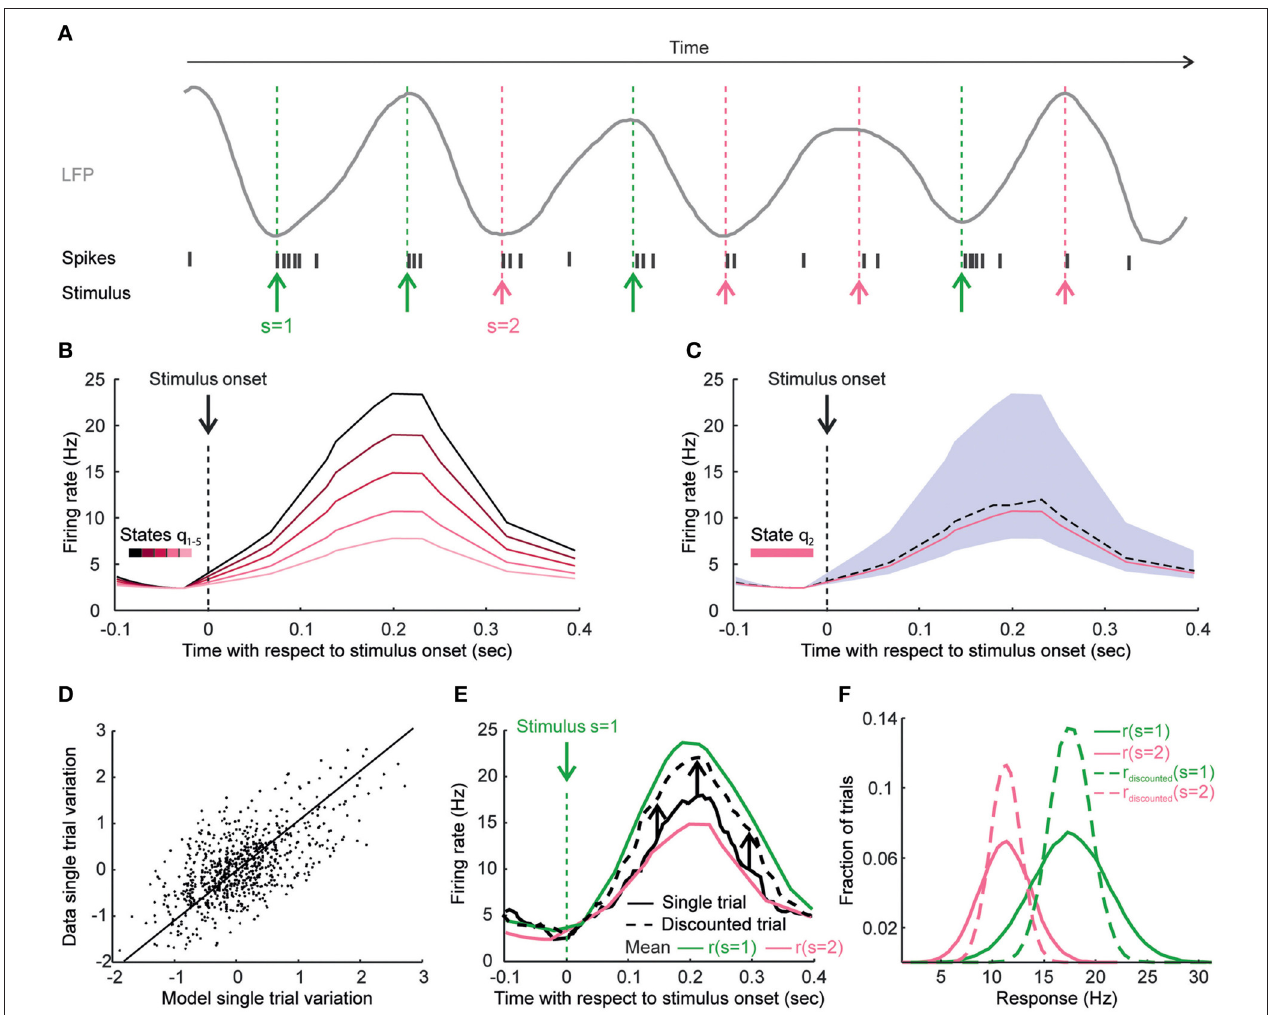
FIGURE 2 | How knowledge of state dependence may be used to improve reliability of elicited patterns and to enhance decoding of neural activity. This figure uses cartoons of neural responses to illustrate how taking into account state dependence of neural responses may improve BMIs. (A) The panel illustrates the responses of a cartoon neuron to two different stimuli presented at different phases of LFP. Green and pink arrows represent the application times of stimulus s = 1 and s = 2, respectively. Stimuli applied at the trough of the LFP (a more excitable network state phase) elicit a stronger response than stimuli applied at the peak of the LFP (a less excitable network state phase). (B) We plot the time course of cartoon neural activity shortly after a stimulus is applied at time t = 0. Different lines represent single-trial responses to the same stimulus that were elicited in trials that differed by the value of the state variable (in this case, the LFP phase) in each trial. Each line representing the single-trial responses is color-coded by the value of the state variable in that trial. The response to the same stimulus has large trial-to-trial variability because of the difference in the state at which the stimulus is presented. (C) In a particular network state, the real response (dashed black line) and the state-dependent model prediction (pink line) of the response are shown. If the model of state dependence is accurate, it will help the experimenter to predict which response will be elicited in that trial given the stimulation parameters and the neural state, thereby narrowing down the uncertainty about which response will be elicited. The gray area shows the range of possible responses that could be obtained for a given stimulus because of state variations. (D) A scatter plot showing the variations around the mean of single-trial responses plotted against the single-trial response variations around the mean estimated from a state-dependent model of the responses in a hypothetical case. Each point represents one trial. This scatter plot indicates how well a state dependence model can predict the single-trial neural responses to a given stimulus. (E) How to discount state-induced trial-to-trial variability is exemplified for a single trial. Stimulus 1 was presented in this cartoon trial, and the response in this trial (full black line) is plotted against the trial-averaged response of stimulus 1 (green line) and of stimulus 2 (pink line). The state dependence model predicts that the response variation around the trial-average in this trial was negative. The black arrows show the model-predicted state-induced variation around the trial-average for this particular single trial. The addition of the model predicted variability gives a “discounted” response (dashed black line) that will be much closer to the averaged response to stimulus 1 (the stimulus actually presented in this trial) that the original response. (F) The distributions of the responses to stimulus 1 (green full line) and stimulus 2 (pink full line) and the distributions of the discounted responses for stimulus 1 (dashed green line) and stimulus 2 (dashed pink line) obtained after subtracting the model predicted state-induced variability are shown. The distributions of the discounted responses are narrower and allow better discrimination between the two